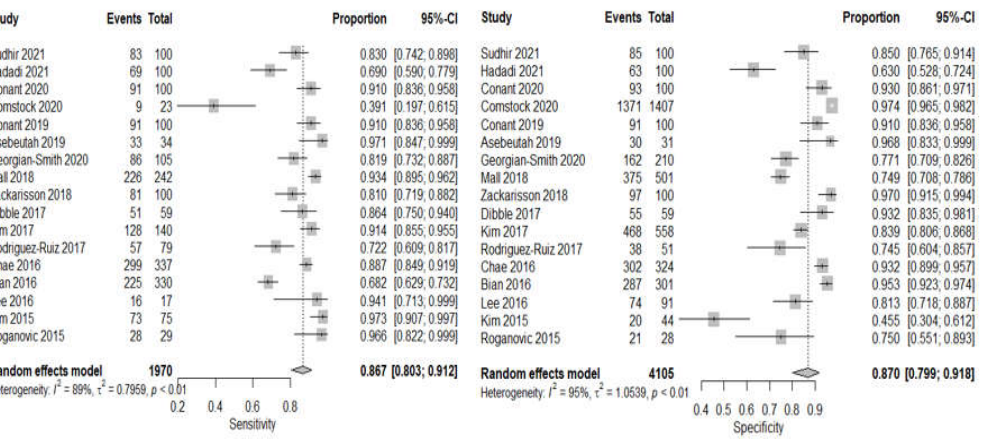
Figure 5. Forest plots using random effect model univariate meta-analysis model for DBT showing pooled sensitivity and pooled specificity.